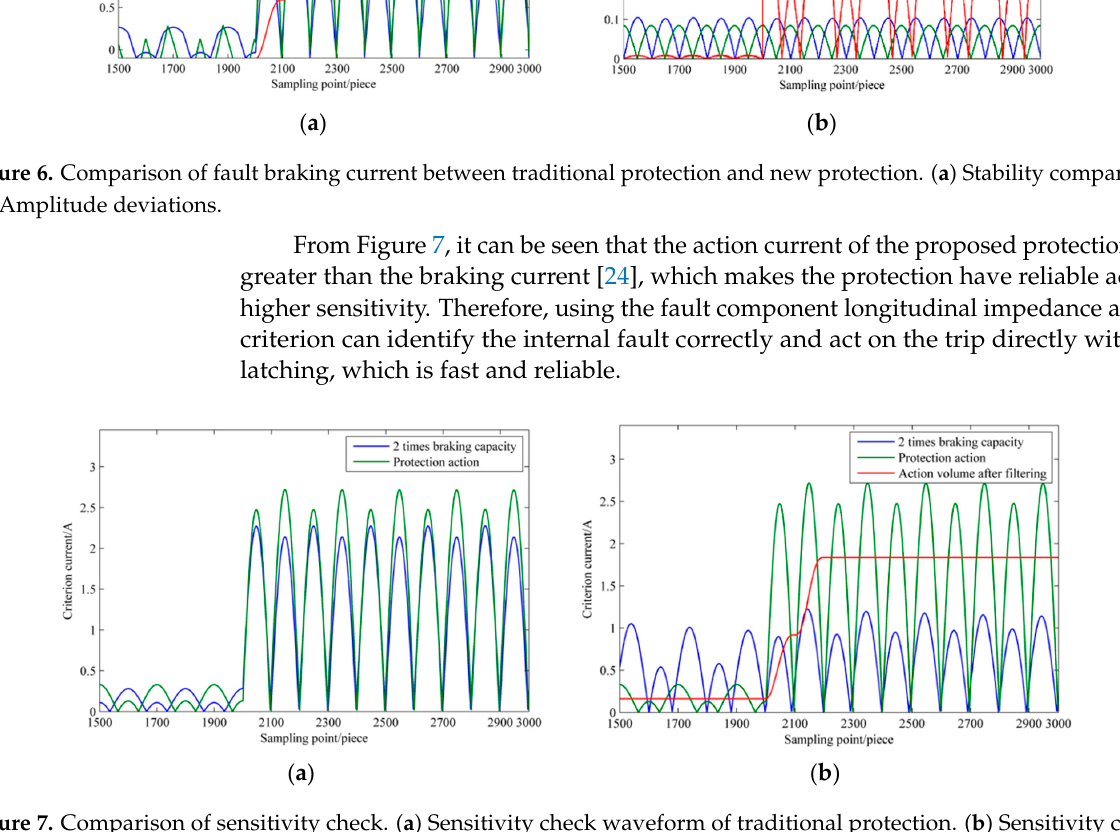
Figure 7. Comparison of sensitivity check. ( a ) Sensitivity check waveform of traditional protection. ( b ) Sensitivity check waveform of new protection.